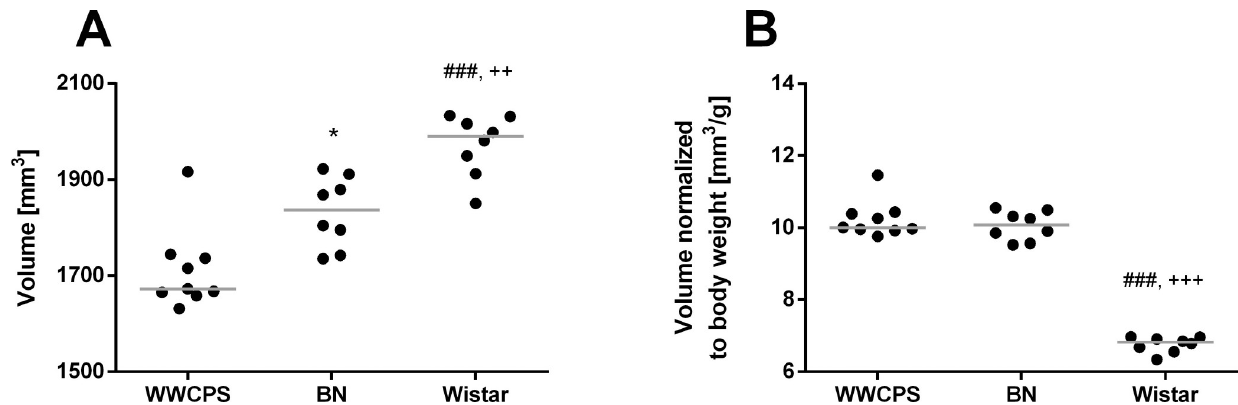
Fig 3. Brain size in WWCPS, BN and Wistar rats. (A) Absolute (ie. non-normalized) volumes expressed in mm 3 . (B) Ratio of brain volume to body weight (normalized values) in WWCPS, BN and Wistar rats. Lines represent medians, dots represent individual values Symbols represent Bonferroni corrected significance levels: � p < 0.017 BN vs. WWCPS; ### p < 0.0003 Wistar vs. WWCPS; ++ p < 0.003, +++ p < 0.0003 BN vs. Wistar.